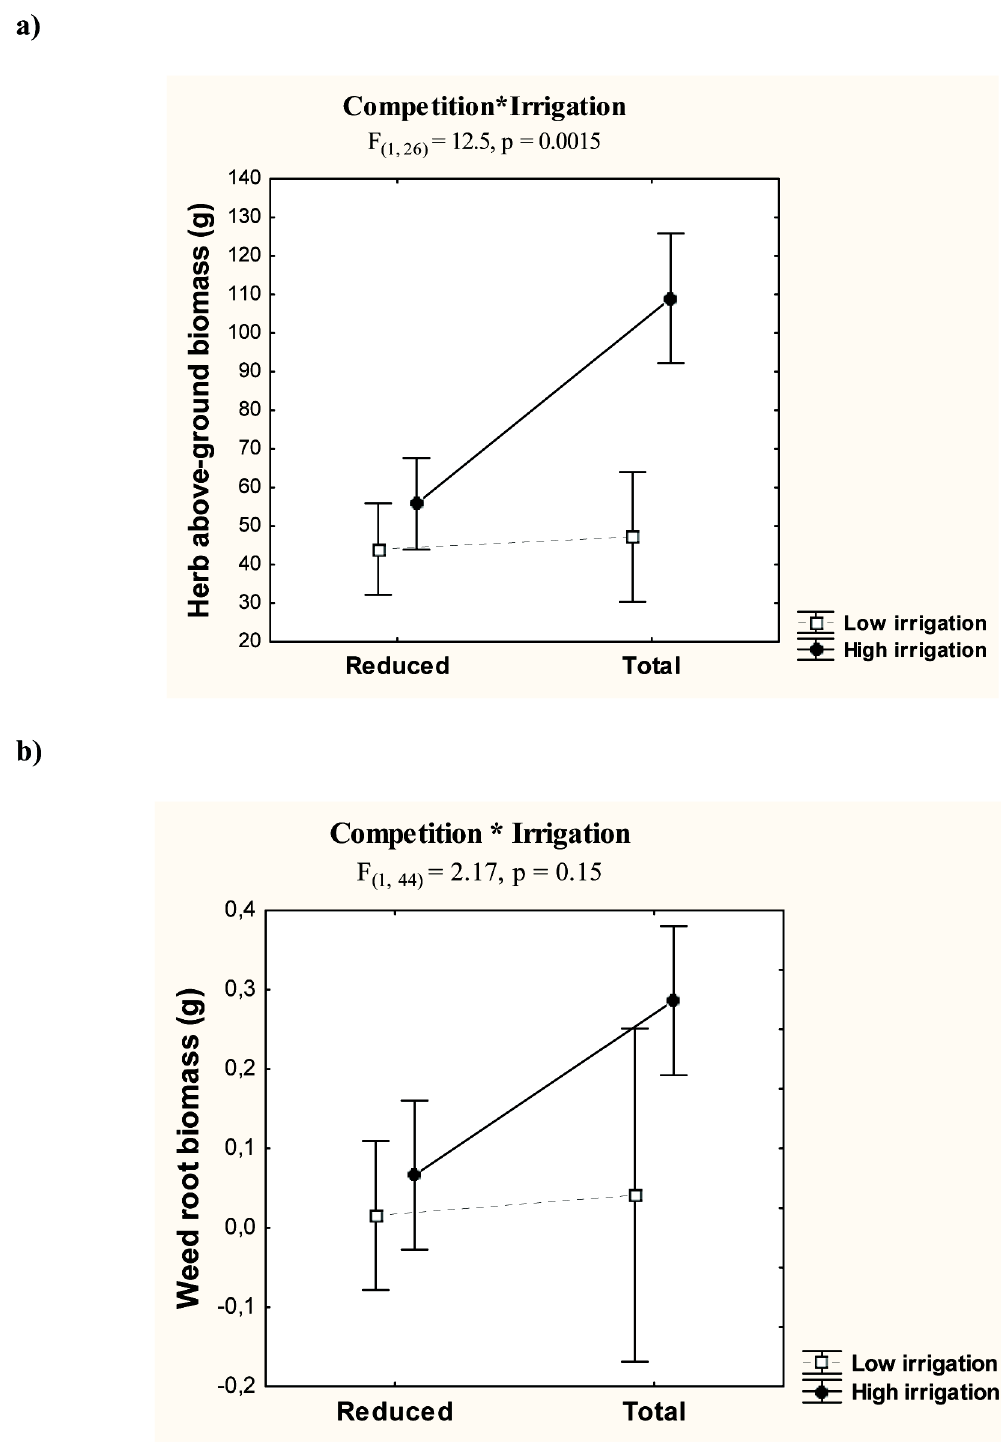
Fig. 2. Interactive effects of herb competition and irrigation on herb production. (a) herb above-ground biomass accumulated through- out the experiment. (b) root biomass of herbs at the end of the experiment. Bars are standard